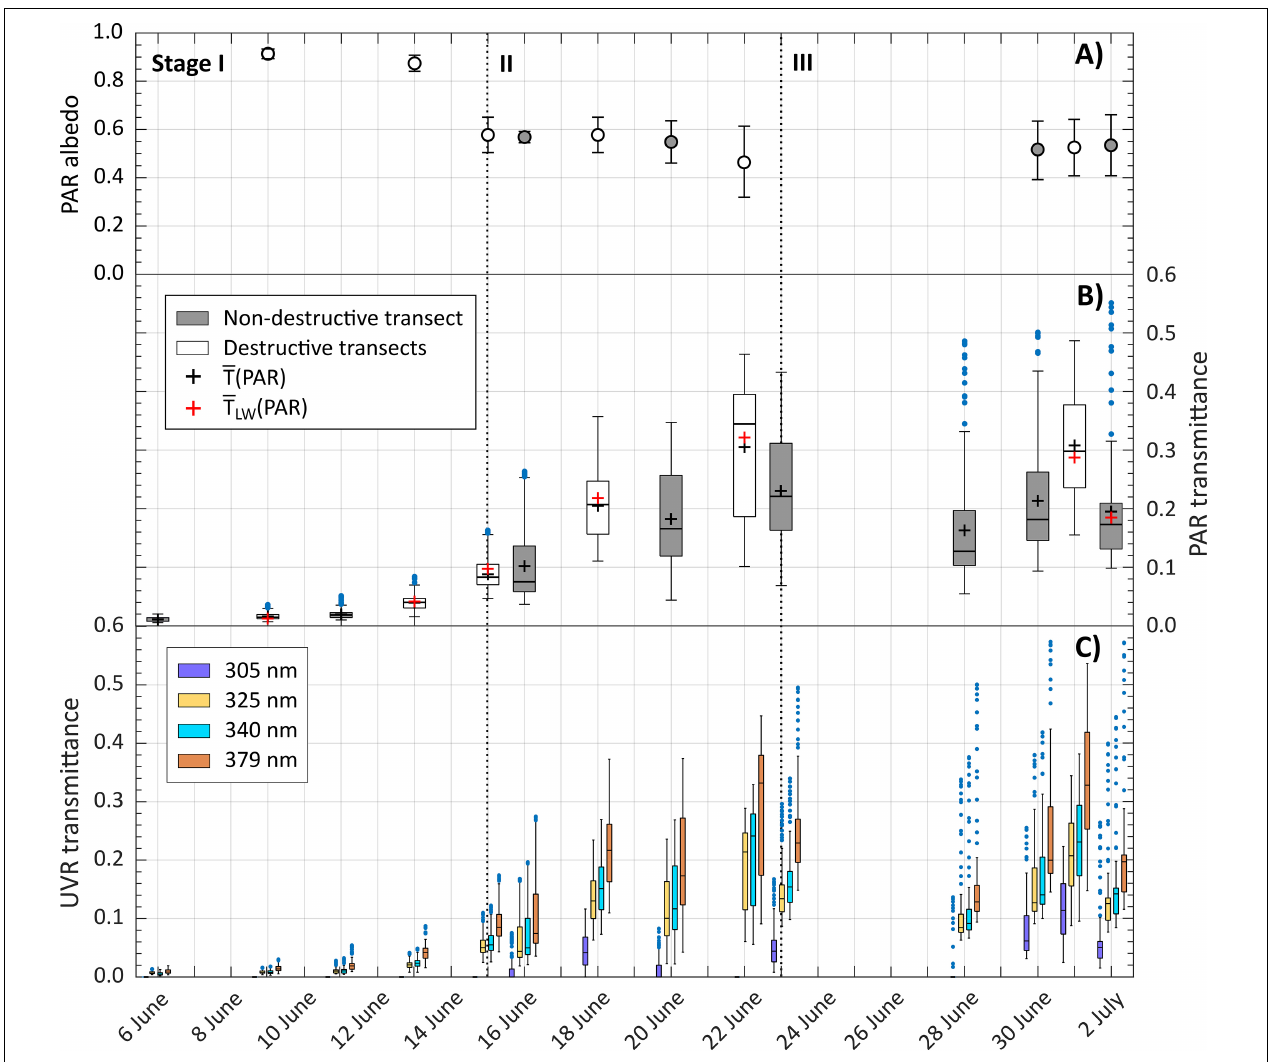
FIGURE 5 | Time series of (A) length-weighted mean PAR surface albedo, (B) PAR transmittance at the sea ice bottom, and (C) UVR transmittance for four wavelengths (305, 325, 340, 379 nm) at 2-m depth over the sampling period. Boxplots of PAR transmittance show median (black bar), mean (black cross), length-weighted mean (red cross) and the 25% and 75% quartiles of measurements along each D transect (gray) and the ND transect (white). Whisker length correspond to ± 2.7 σ , outliers are shown as blue dots. The beginning of melt stages (I – III) is highlighted as dotted lines.